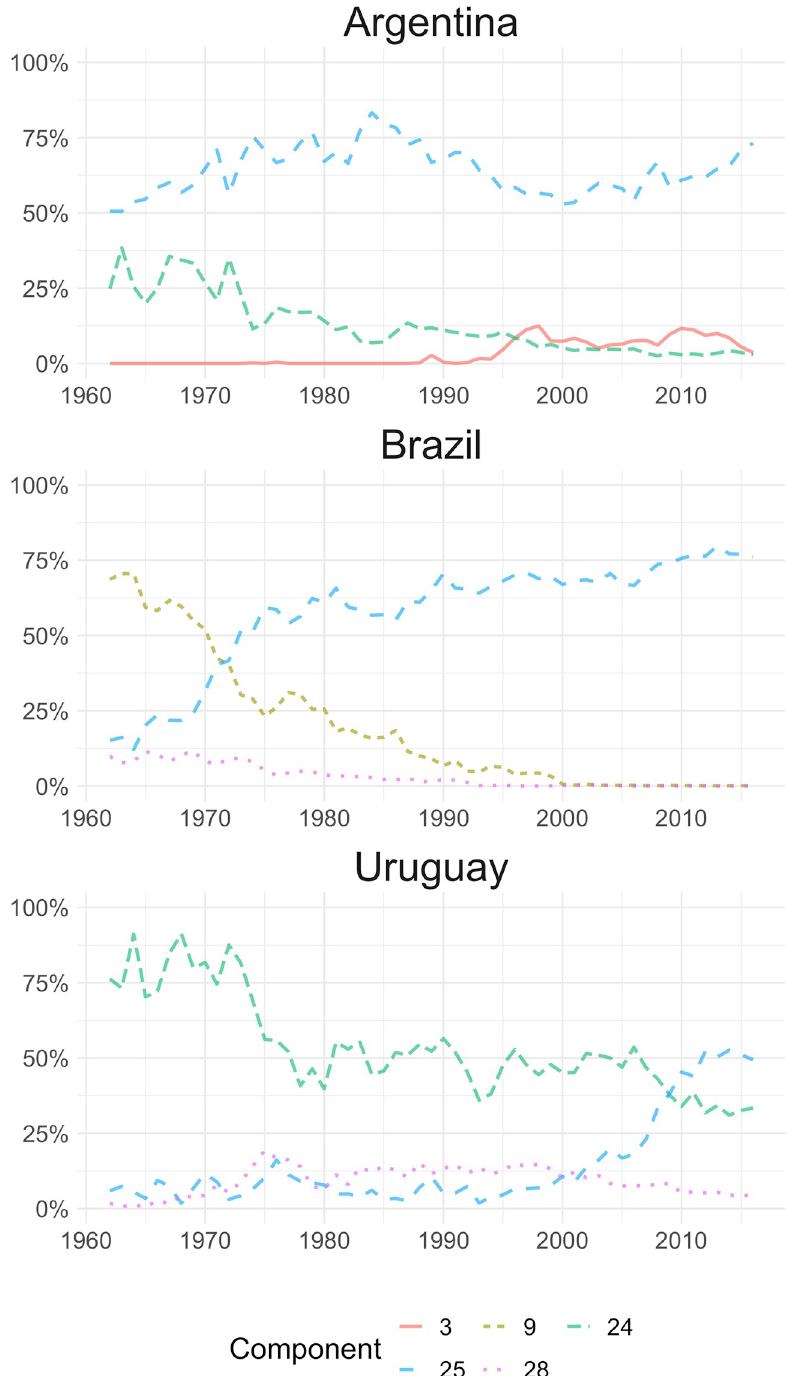
Fig 2. LDA outputs for Argentina, Brazil and Uruguay. Distribution of the top three components by country. 3: Vehicles and parts; 9: Coffee, bananas, other food and primary products; 24: Boats, meat, fish, dairy; 25: Soya and derivatives, Iron; 28: Rice, cotton,